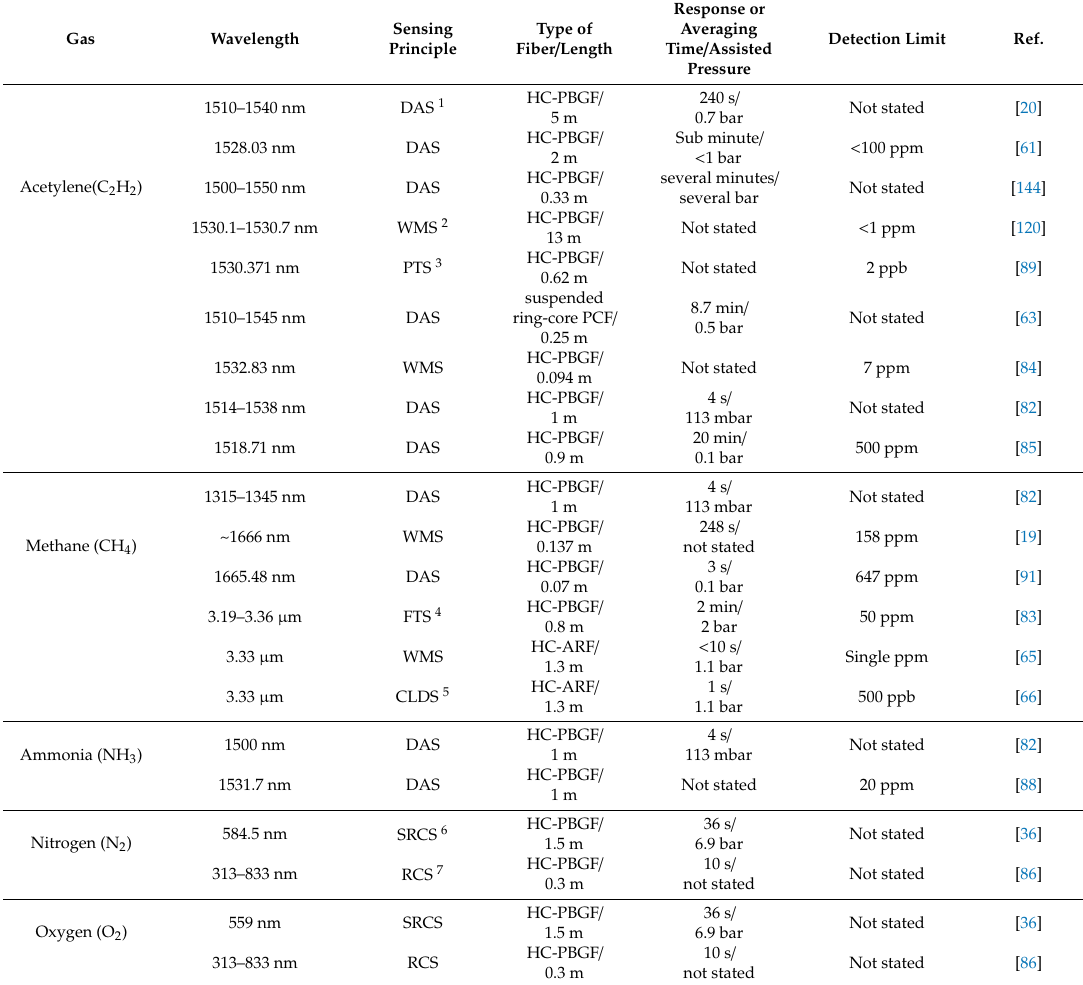
Table A1. Comparison of performance indicators for di ff erent HC-PCF gas